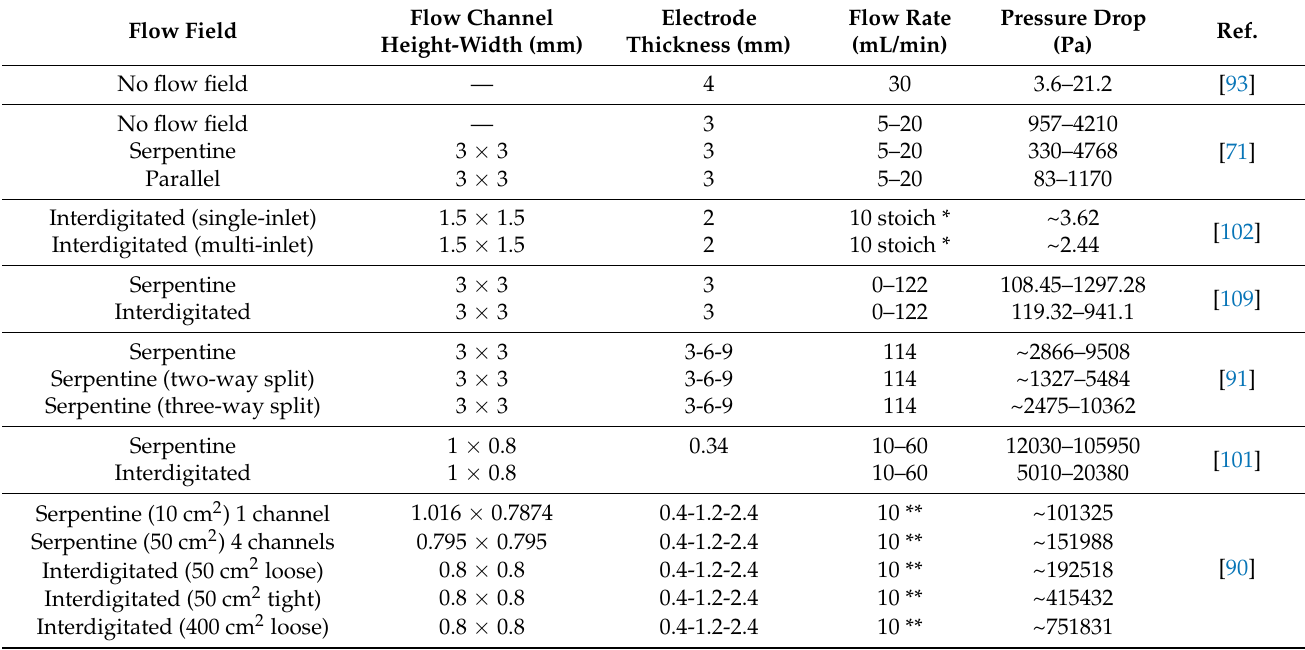
Table 4. VRFBs main parameters and pressure drop values from different flow field